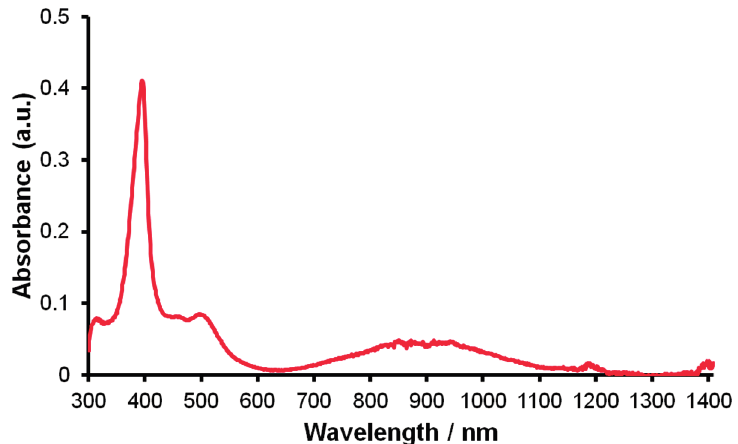
Figure 3. UV/Vis/NIR spectrum of 2 (0.1 mM in THF).